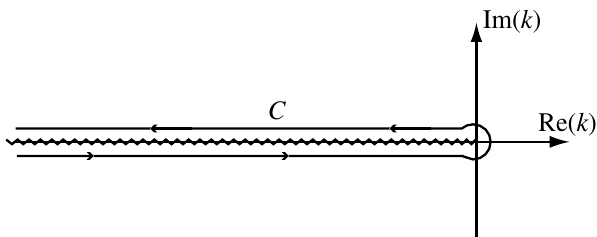
FIG. 2. The Hankel contour in the complex k plane is taken around the (cid:11)1 < k < 0 branch